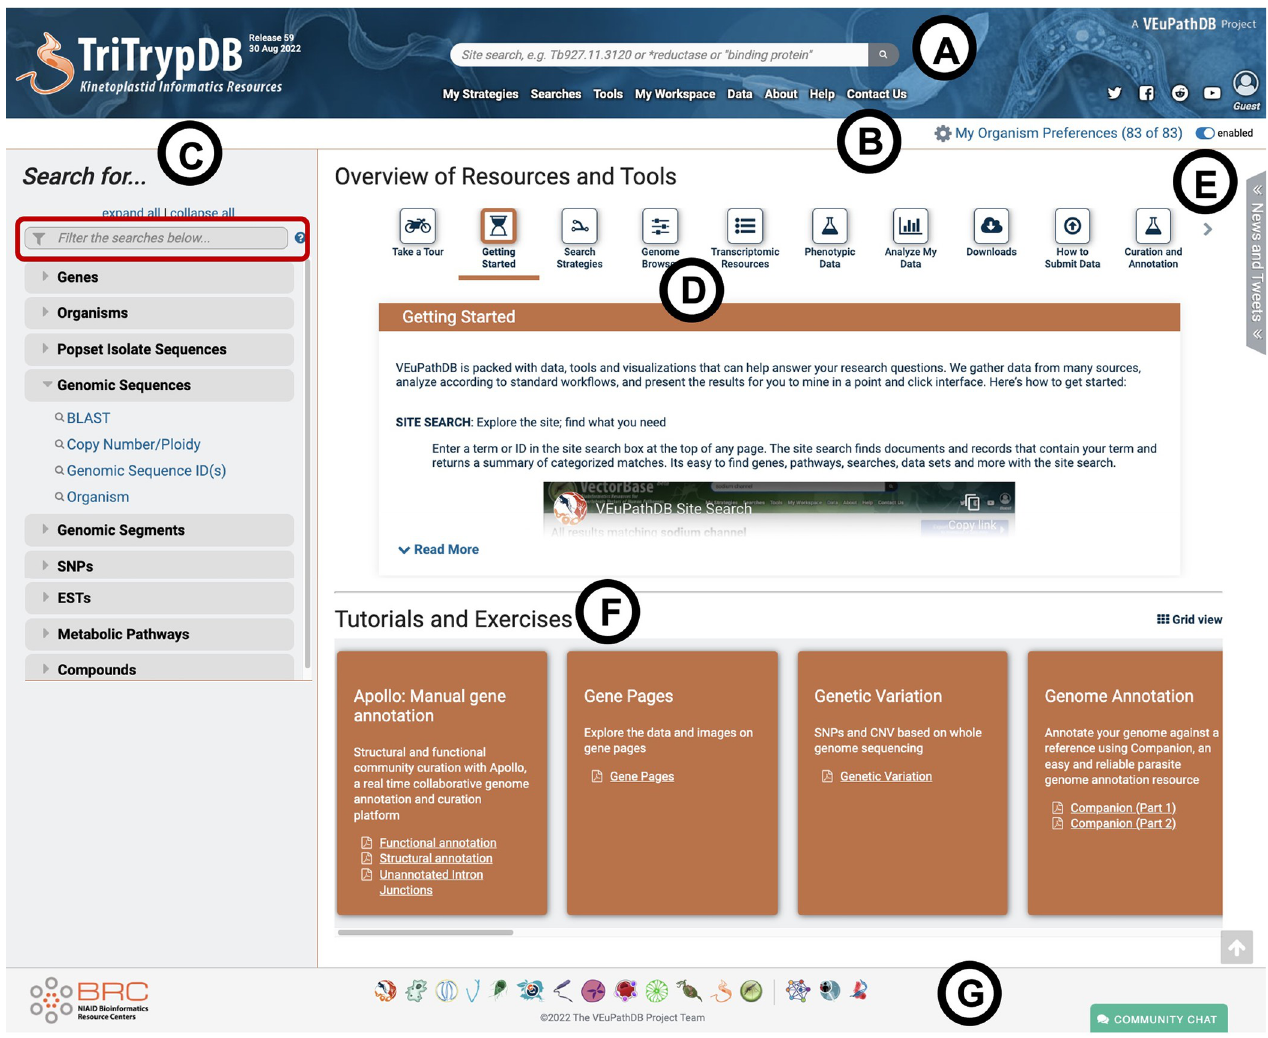
Fig 1. Home page of TriTrypDB. (A) Header on all site pages that includes site search, menu bar providing access to all searches, data and tools, and links for social media, registration, login and user profile. (B) The recently implemented ‘My Organism Preferences’ filter. (C) The left hand search panel contains searches of different data in the database, organized into categories. (D) The overview of resources and tools section provides vignettes to help users get started on specific tools and resources of interest. (E) The expandable news and tweets section (collapsed by default) offers quick access to news releases and recent tweets. (F) Links to more detailed step-by-step instructional material. (G) Footer consisting of hyperlinked logos to other VEuPathDB resources in addition to the Gitter Community Chat button.